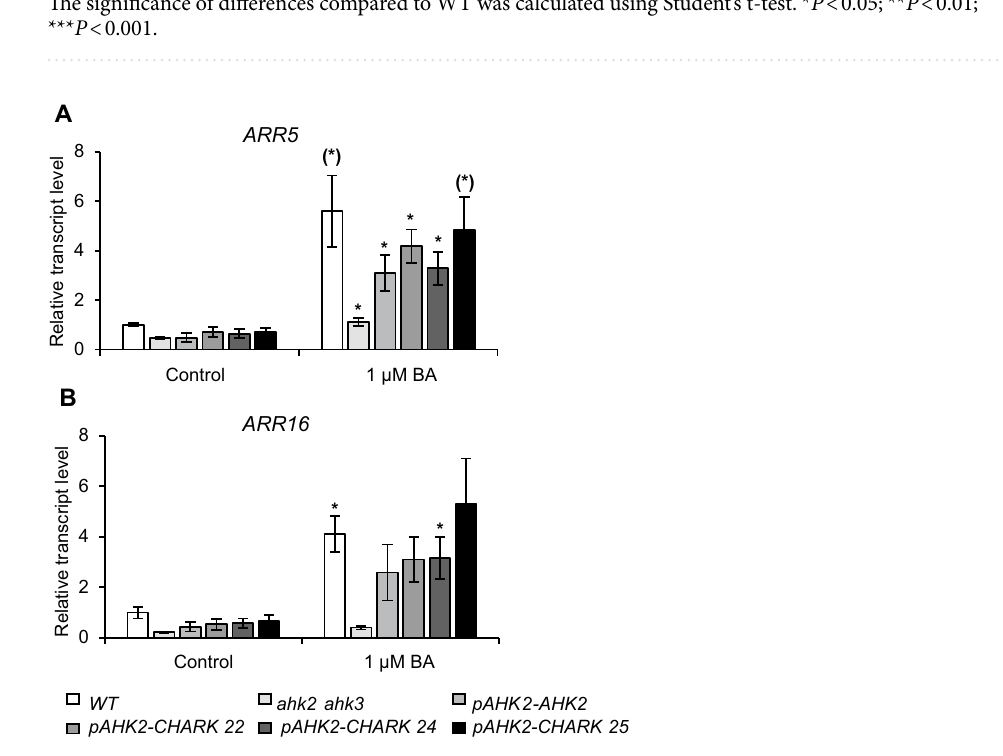
Figure 7. CHARK mediates the activation of cytokinin response genes in A. thaliana. Induction of ( A ) ARR5 and ( B ) ARR16 expression by cytokinin in WT, ahk2-2 ahk3-3 , pAHK2-AHK2 , and three independent lines expressing pAHK2-CHARK in the ahk2 ahk3 mutant background. Two-weeks old seedlings were treated for 1 h with 1 µM BA. Expression levels of ARR5 and ARR16 were analyzed by qRT-PCR. Data represent mean values (± SE) (n = 4). Student’s t-test was used to calculate the significance of differences between cytokinin-treated samples and untreated samples. * P ≤ 0.05; ( * ) P =